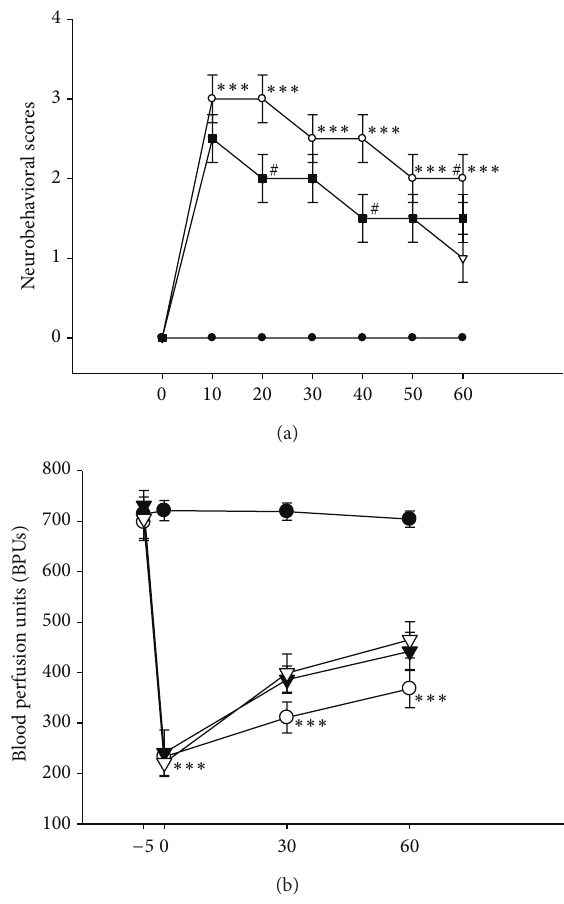
Figure 2: Effects of the extract of A. camphorata on (a) neurobehav- ioraldeficitsand(b)bloodperfusionunit(BPU)inthromboembolic stroke-induced rats. (a) shows neurobehavioral deficits in 4 experi- mental groups; (b) shows BPU of solvent and A. camphorata or the aspirin treated rats were measured by laser Doppler flowmeter in the MCAO-supplied cortex. Data are presented as the means ± S.E.M. of three similar experiments. ∗∗∗ 𝑃 < 0.001 compared to the sham- operated group; # 𝑃 < 0.05 compared to the MCAO